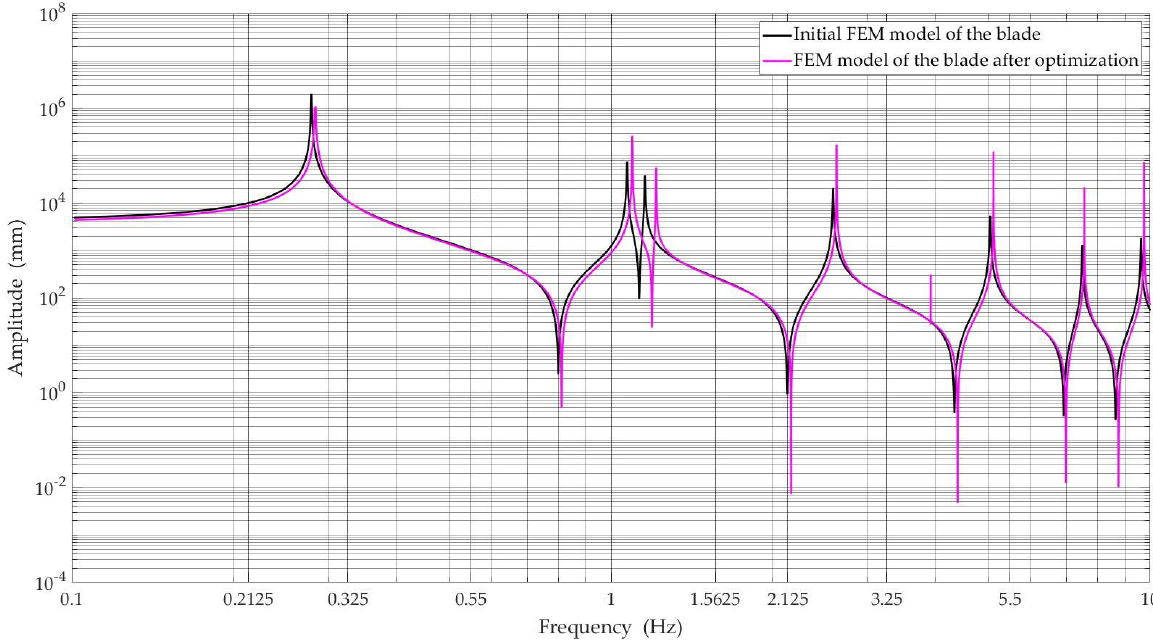
Figure 10. Amplitude-frequency characteristics were determined in the node located in the tip blade for the initial FEM model and FEM model after